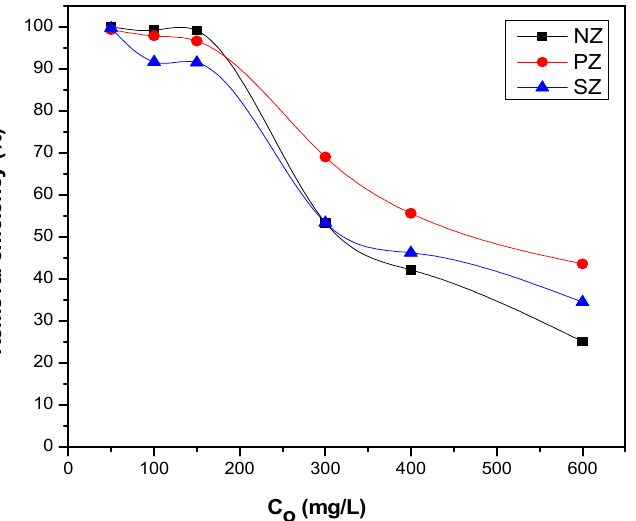
Figure 15. The thorium removal efficiency by NZ, PZ, and SZ using various initial thorium concen- trations. Experimental conditions were as follows: adsorbent media 0.03 g/2 mL; pH 3 and 24 h as contact time at room temperature 25 °C.